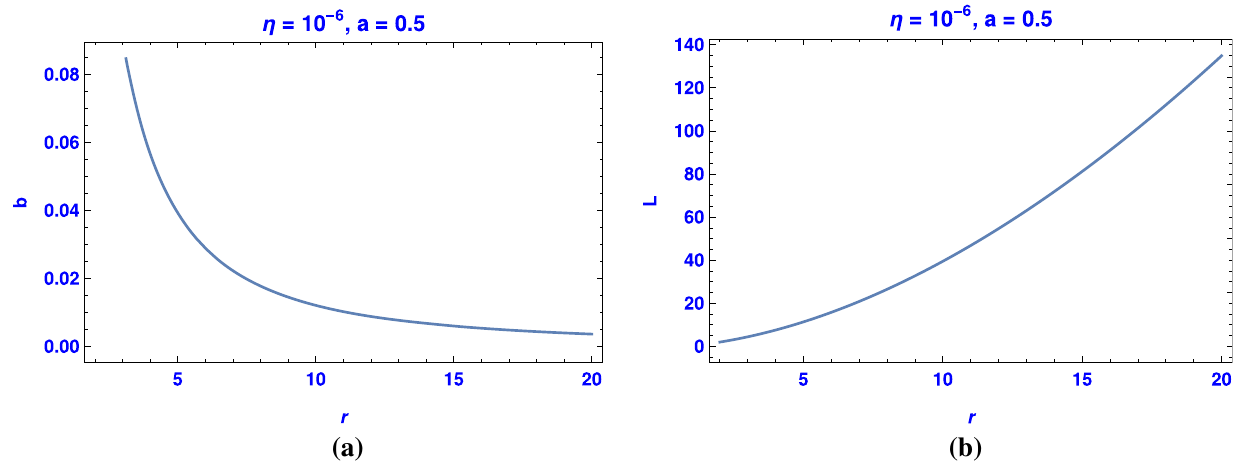
Fig. 6 Here we have plotted the critical values of angular momentum and magnetic field at ISCO positions